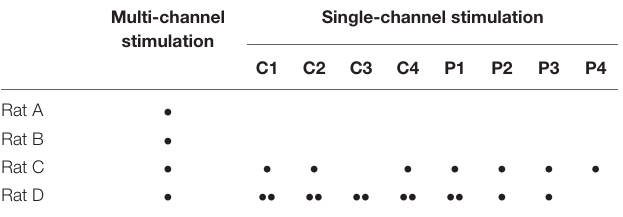
TABLE 1 | Summary of data